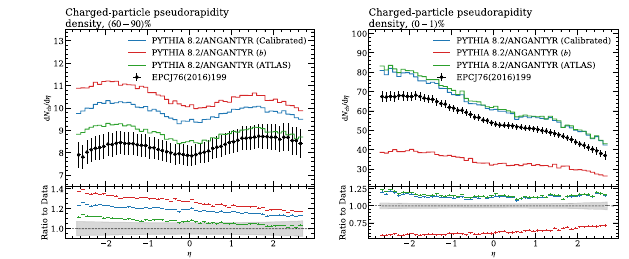
√ = 5 . 02TeV s Fig. 9 Charged-particle pseudorapidity density as a function of pseu- NN dorapidity in p–Pb at and central (0–1%) (right) events [41], compared to Pythia 8.2